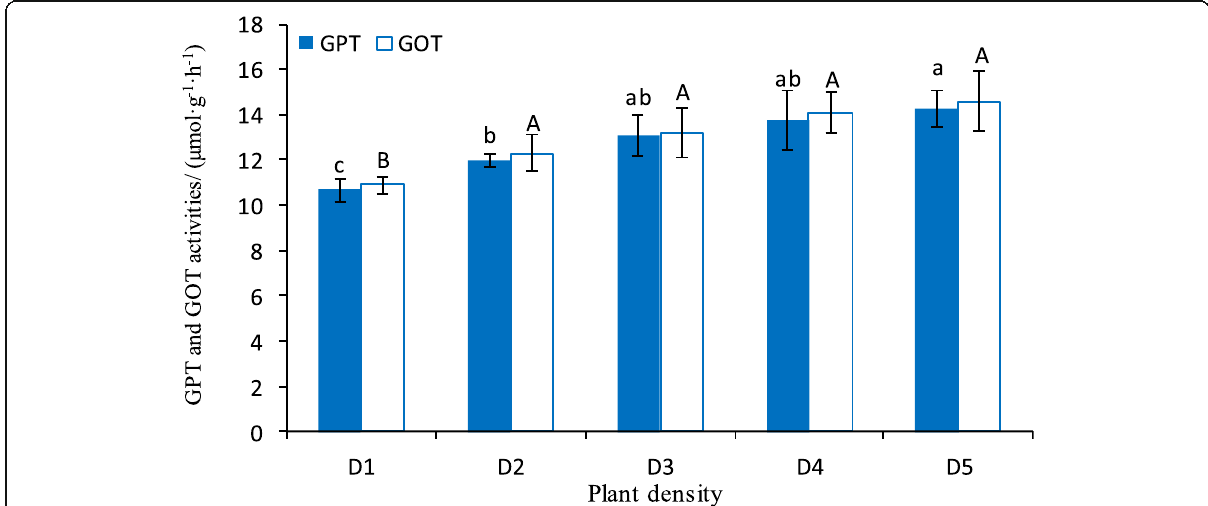
Fig. 4 The GPT and GOT activity in boll wall under different planting densities in 2018. D1-D5: 15 000, 25 000, 45 000, 60 000, and 75 000 plants per hectare. The vertical bar represents S.E. of the mean ( n =3) when the value exceeds the size of the symbol. Lowercase letters indicate significance analysis among GPT activity, and capital letters indicate significance analysis among GOT activity. The same letter among treatments is not significantly different ( P ≥